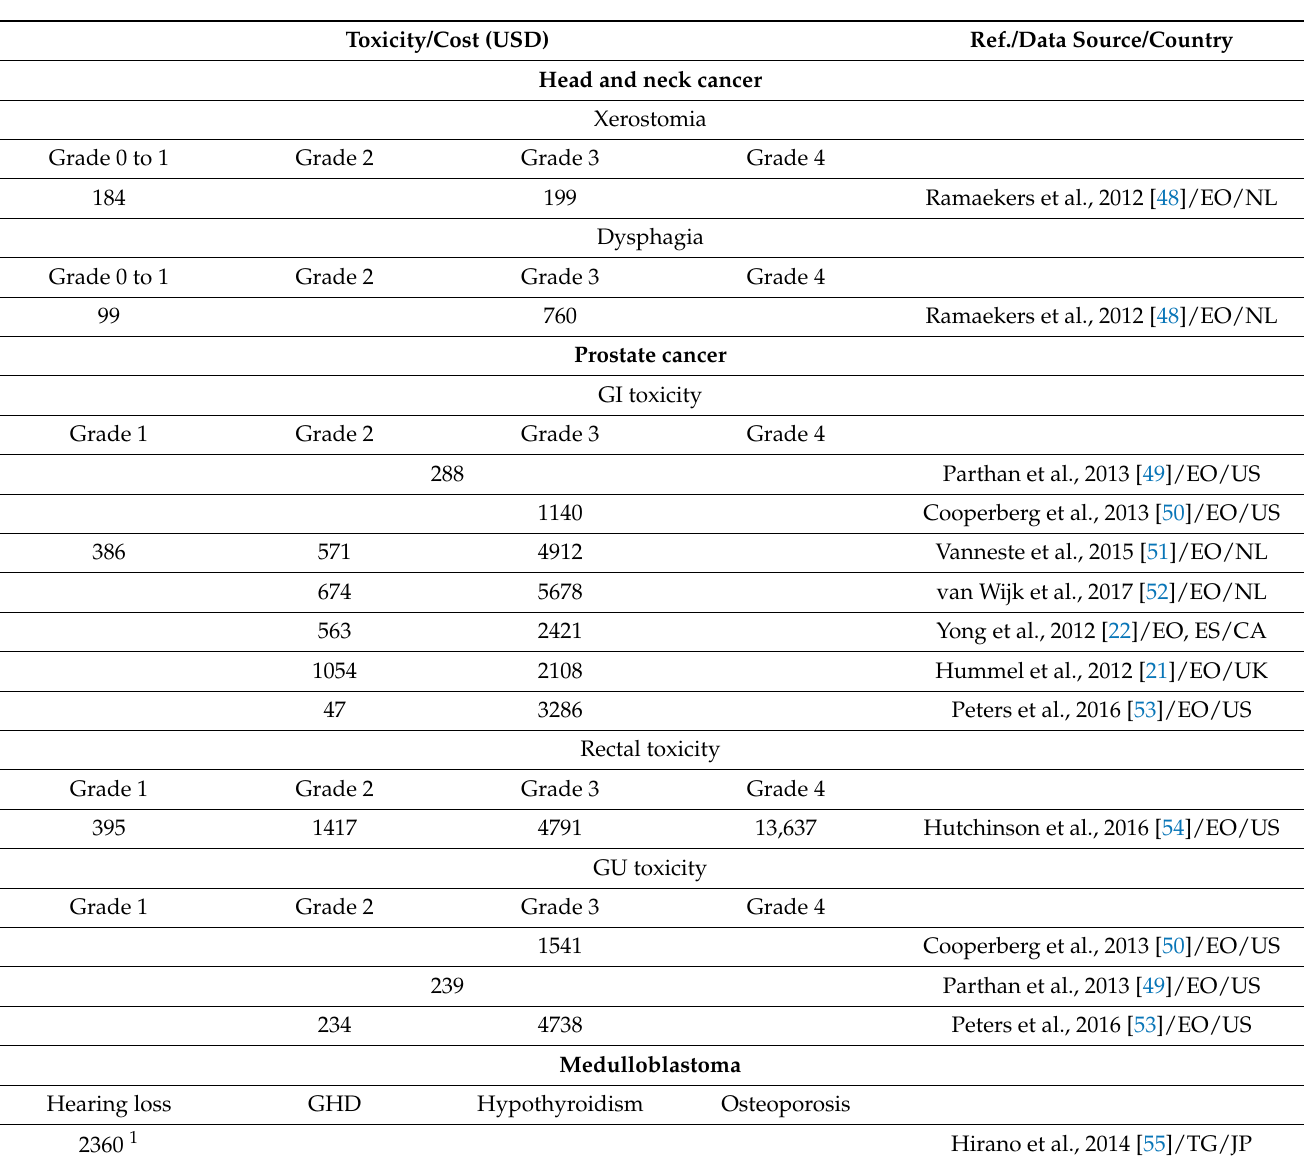
Table 5. Healthcare costs reported by modeling